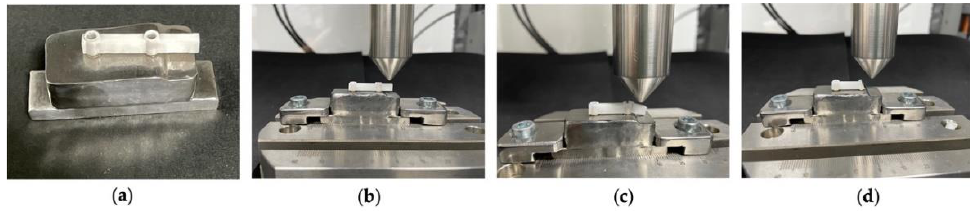
Figure 3. Fracture resistance tests. ( a ) Titanium-based bolted structure; ( b ) start of the static load, 2 mm from the end of the cantilever arm; ( c ) fracture of the 6 mm cantilever; ( d ) fracture of the 10 mm cantilever.